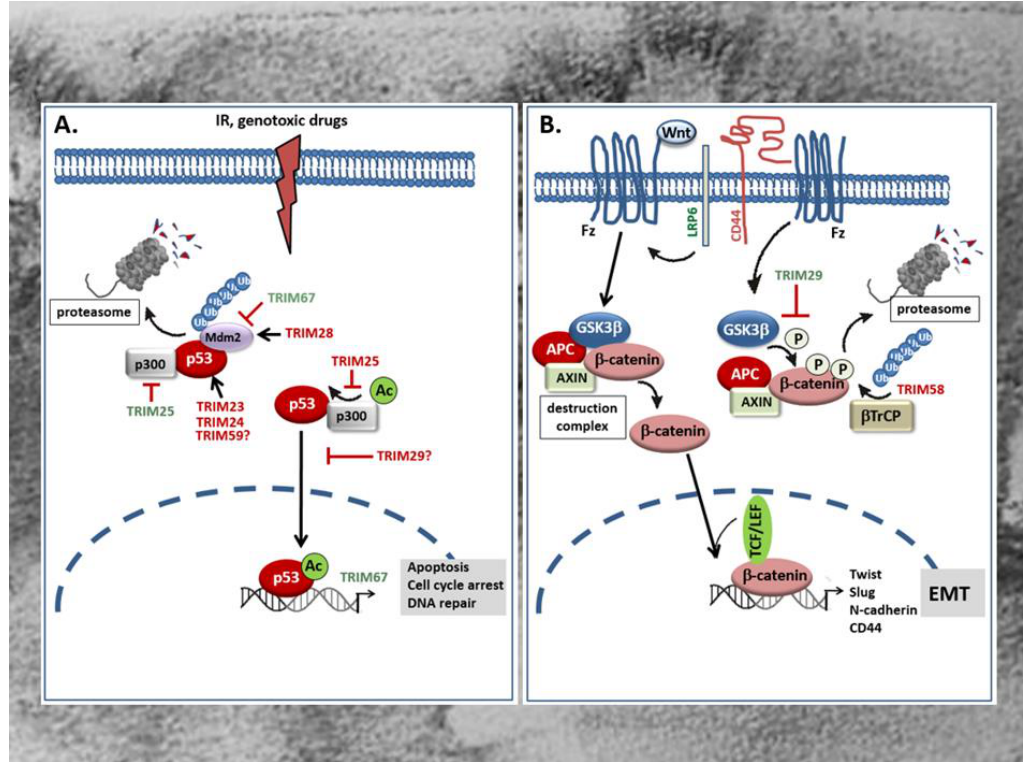
Figure 2. ( A ) Role of TRIMs in the control of p53 tumor-suppressor protein. TRIM proteins modulate the tumor suppressive activity of p53 e.g., in response to irradiation (IR) or genotoxic drugs via diverse mechanisms. P53 antagonizing TRIM proteins (red) can either directly interact with p53 and thereby promote p53 ubiquitination and proteasomal degradation or indirectly, via facilitating the association with the ubiquitin ligase Mdm2 which targets p53 for proteasomal degradation. Alternatively, the p53 negative regulatory TRIM25 interferes with the transactivation potential of p53 and consequently with the transcription of p53 controlled genes due to an impaired formation of a ternary p53 activation complex of p53, Mdm2, and p300 which is critical for p53 acetylation (Ac). Instead, the p53 inhibitory TRIM29 upon p300 dependent acetylation binds to p53 and enhances the sequestration of p53 in the cytoplasm thereby preventing p53-triggered transcription of p53 target genes relevant for tumor suppression. By contrast, some TRIMs promote stabilization of p53 either though directly binding to Mdm2 thereby preventing p53 proteasomal degradation (TRIM67) or by preventing the formation of a ternary complex of p53, Mdm2, and p300 which is also critical for p53 degradation as depicted for TRIM25. IR: irradiation; Mdm2: mouse double minute 2. ( B ) Opposing modulatory e ff ects of TRIMs on Wnt / β -catenin signaling in the GI tract. TRIM29 induces Wnt / β -catenin signaling mainly through inhibition of β -catenin phosphorylation by GSK3 β thereby preventing β -catenin degradation by the proteasome. Consequently, β -catenin can translocate into the nucleus and in a complex with TCF or LEF activate TCF / β -catenin-responsive genes including mesenchymal marker genes of EMT such as N-cadherin, Twist, Slug, and CD44. The increase in CD44 through its physical interaction with LRP6 can further enhance the Wnt-induced signaling processes. In contrast, TRIM58 inhibits β -catenin-dependent signaling by increasing β -catenin ubiquitination and proteasome-mediated degradation. TRIMs with a stimulatory e ff ect on the Wnt / β -catenin pathway are marked in green; TRIMs with an inhibitory e ff ect are red labelled. APC: Adenomatous polyposis coli; β -TrCP: β -transducin repeat-containing protein; Fz: frizzeled; GSK3: glycogen synthase kinase 3; LRP: lipoprotein receptor-related protein; TCF / LEF T-cell transcription factor / lymphoid enhancer